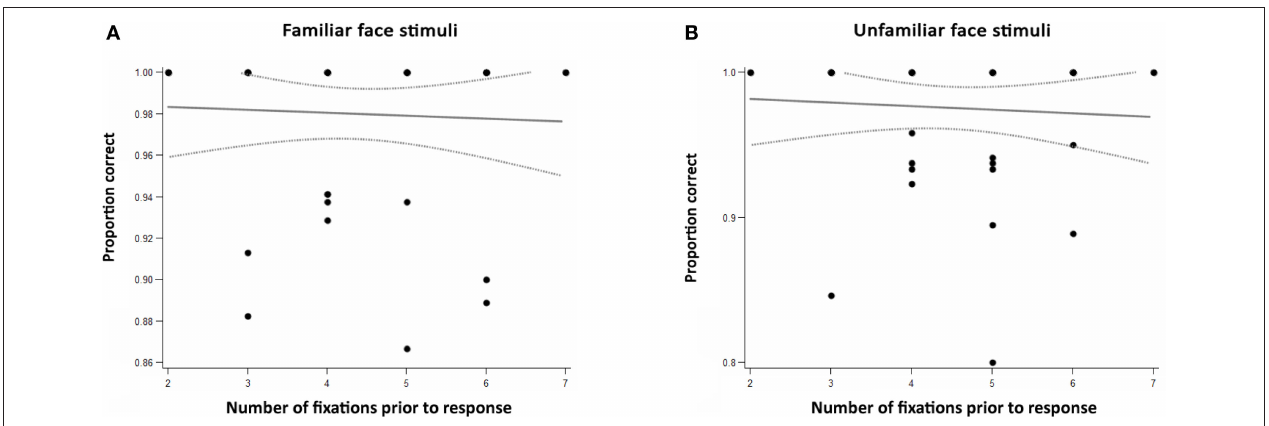
fixations. As indicated by the regression line and confidence intervals, there was no significant correlation between individual accuracy and number of fixations, neither for familiar, nor unfamiliar faces